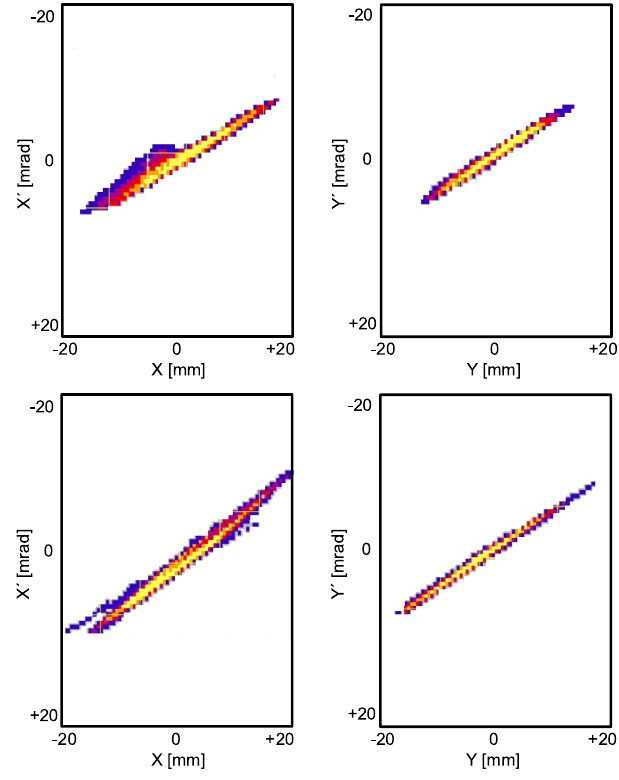
FIG. 17. Transverse Ar 9 þ -beam emittance at 1 . 366 MeV/u (top) and at 1 . 85 MeV/u (bottom); normalized (horizontal) emittance growth is measured for